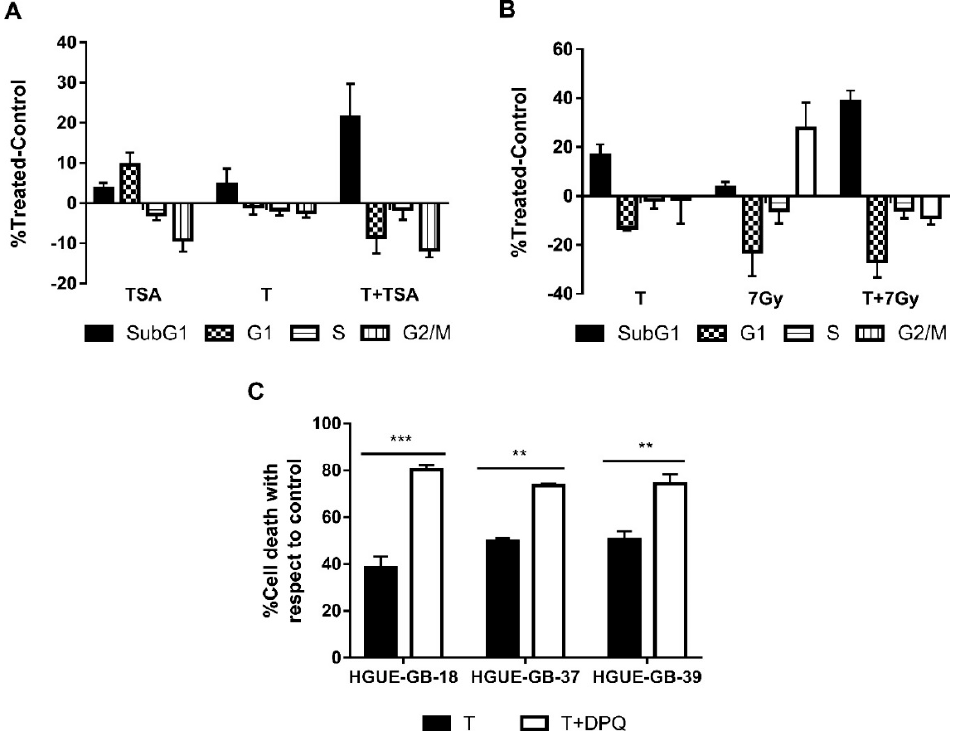
Figure 8. CLytA-DAAO as an enhancer of other treatments. ( A ) HGUE-GB-18 glioblastoma cell line was treated with 0.1 μ M Trichostatin A (TSA) or 1 U mL − 1 CLytA-DAAO and 1 mM D-Ala or a combination of both treatments over 24 h and cell cycle distribution was determined by flow cytometry. ( B ) RWP-1 pancreatic adenocarcinoma cell line was treated with 1 U mL − 1 CLytA-DAAO and 1 mM D-Ala or 7 Gy radiotherapy or a combination of both treatments for 24 h and cell cycle distribution was determined by flow cytometry. ( C ) HGUE-GB-18, HGUE-GB-37, and HGUE-GB-39 glioblastoma cell lines were treated with 10 µ M DPQ or 2 U mL − 1 CLytA-DAAO and 1 mM D-Ala or a combination of both treatments over 24 h and viability was determined by flow cytometry. Data represent the mean ± SEM of the percentages of cells with respect to control, with n ≥ 3. ** indicates p < 0.01, and *** p <